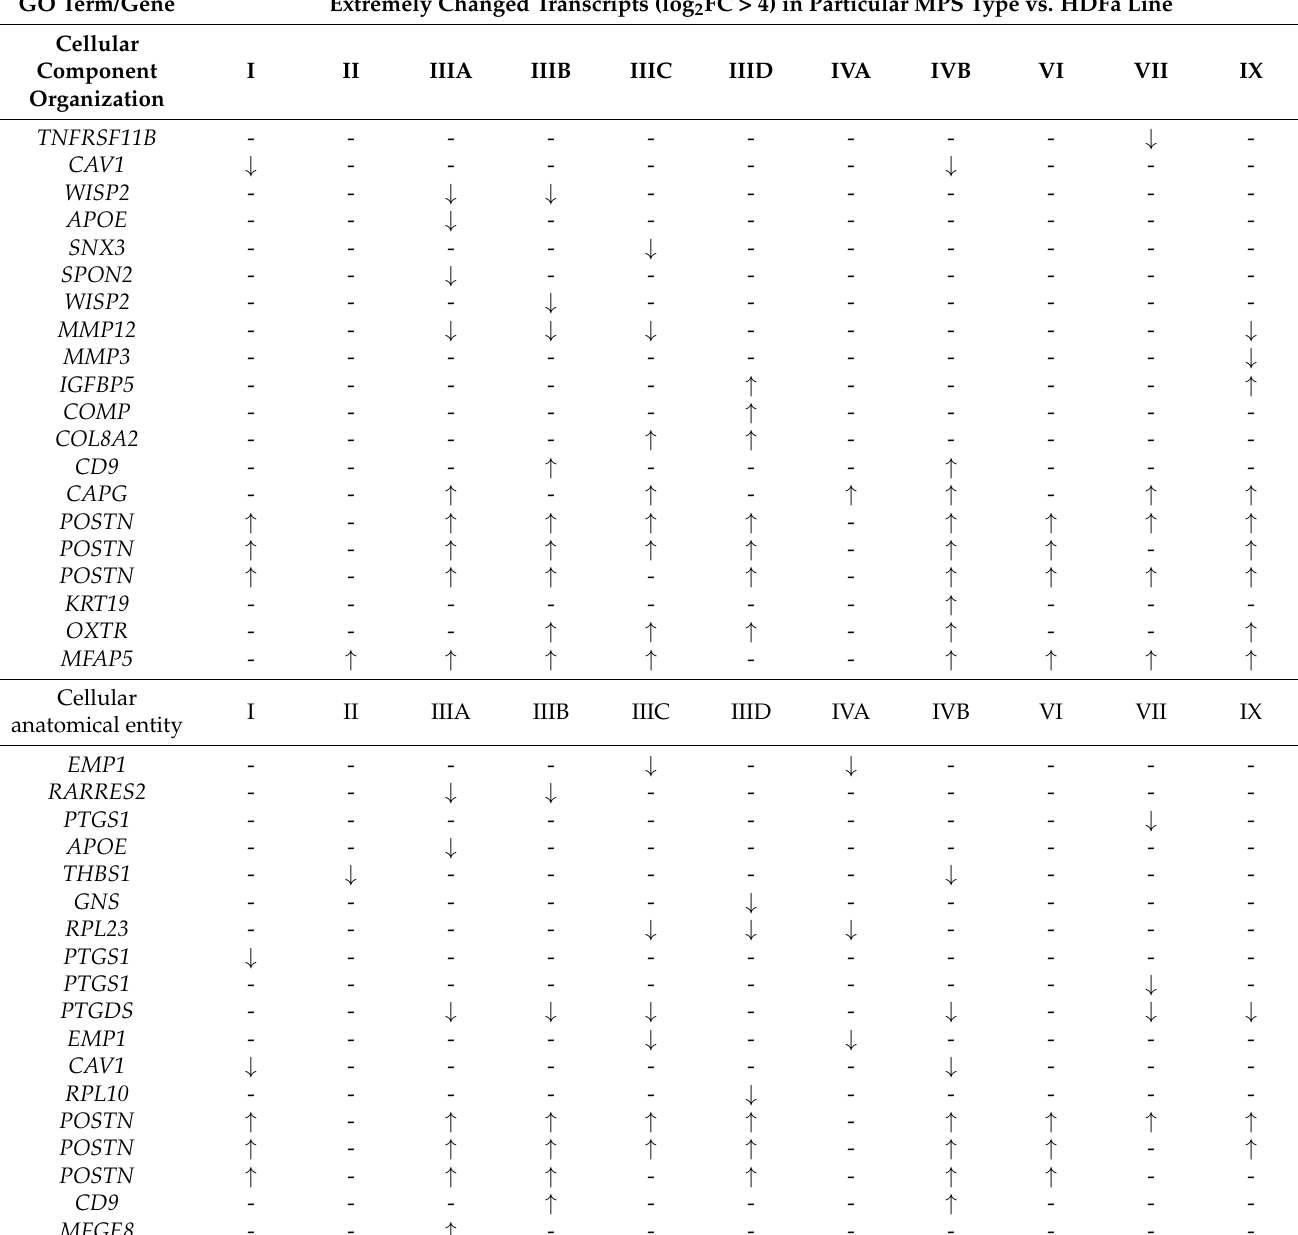
Table 3. Genes with log 2 FC > 4.0 in specific MPS type relative to control cells (HDFa). Up-arrowed and down-arrowed symbols indicate up- and downregulation, respectively, while minus symbols indicate no significant